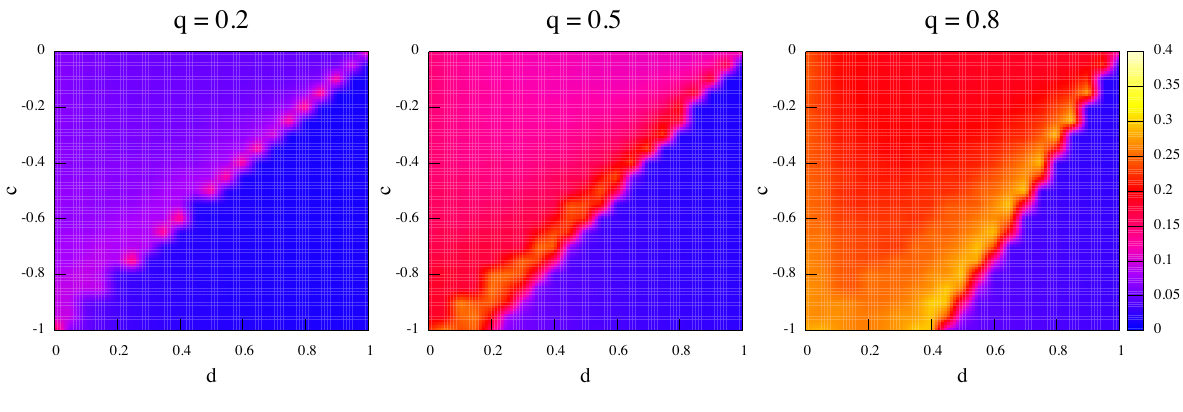
Figure 10. Average clustering coefficients of steady-state networks; relinking frequency q increases from left to right. Equal initial proportions of α and β strategies and strategy update is by best